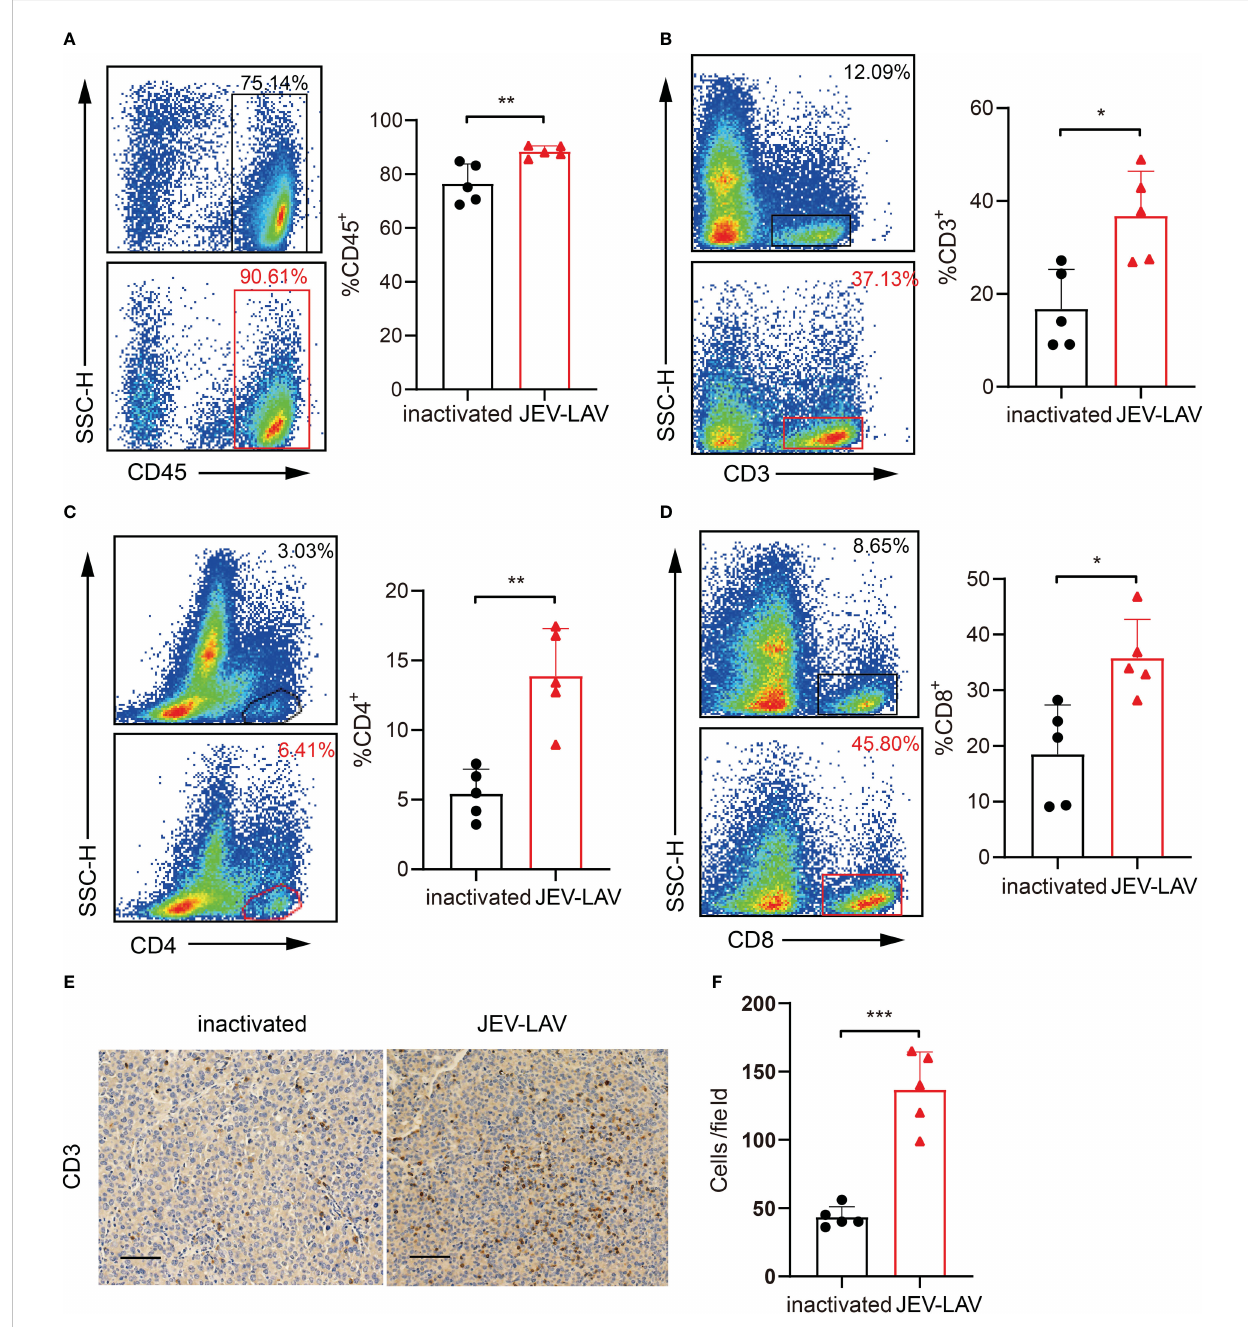
FIGURE 4 JEV-LAV treatment increases the in fi ltration of CD8 + T-cells into the tumor tissues. C57BL/6J mice were intracranially implanted with 1 × 10 5 GL261-luc and injected intratumorally with 1.6 × 10 6 PFU JEV-LAV or inactivated JEV-LAV after 5 days. On day 17 after tumor implantation, the tumors were harvested, dissociated, stained with fl uorescent dye-conjugated anti-mouse antibodies, and analyzed by multicolor FACS. Representative fl ow cytometry scatter plots and statistical analyses of the percentage of (A) CD45 + cells, (B) CD3 + cells, (C) CD4 + cells in CD3 + cells, and (D) CD8 + cells in CD3 + cells. (E) Representative images of CD3 immunohistochemical staining of the coronal brain sections at day 17 of tumor inoculation. Scale bars = 50 m m. (F) Quanti fi cation of the numbers of CD3 + cells in each fi eld of view of the microscope at 20×. The cell counts were obtained from at least three random fi elds/tumor sections. n = 4 or 5 per group. *P<0.05, **P<0.01,